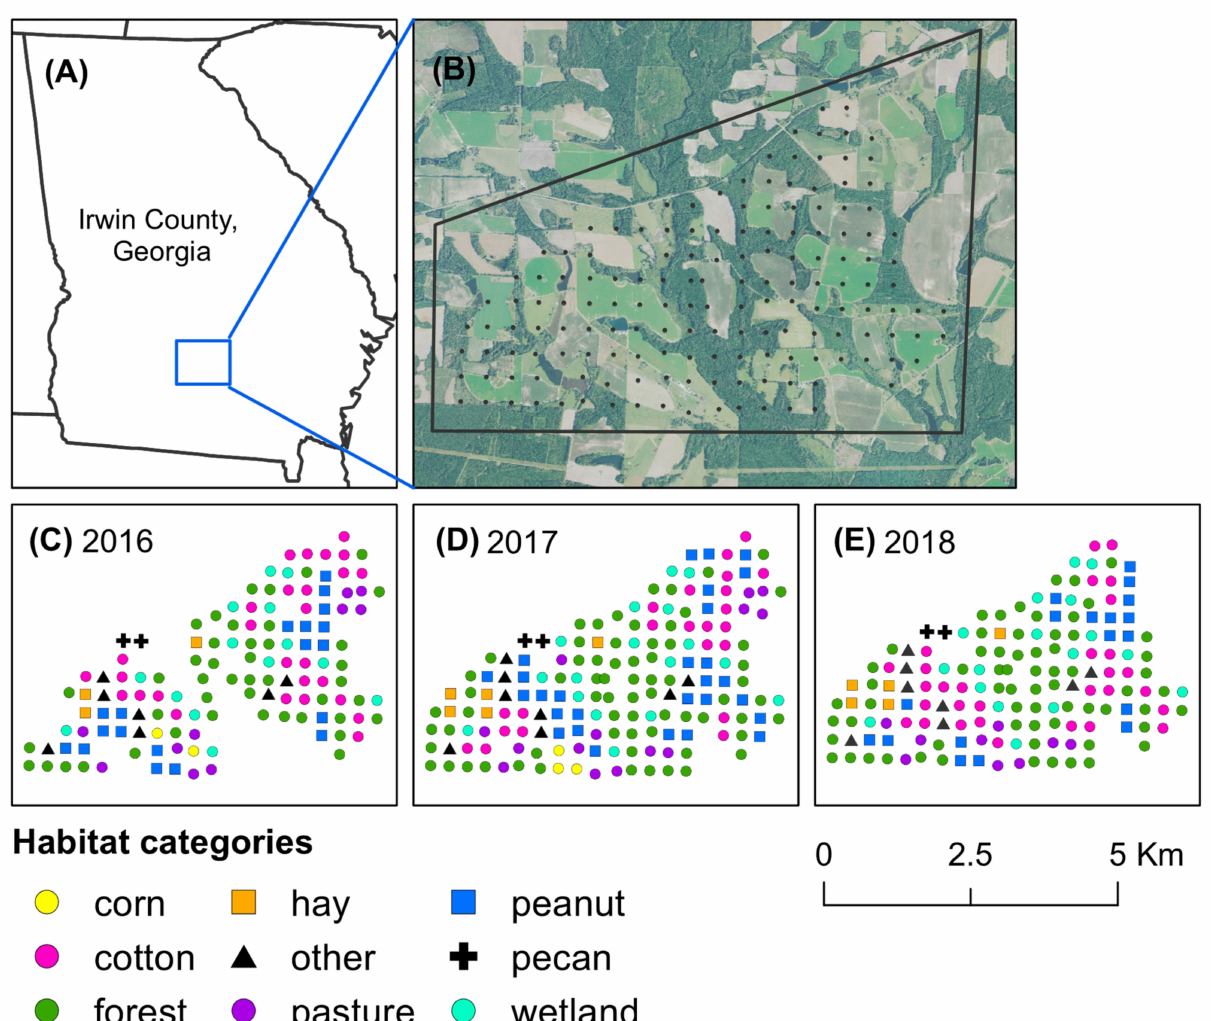
Figure 1. Map of Irwin County, Georgia, USA, and habitat categories at pheromone-baited traps. The study took place in ( A ) Irwin County, Georgia, where stink bugs were captured across ( B ) an 18 km 2 agricultural landscape. Habitats at each trap site were categorized for ( C ) 2016, ( D ) 2017, and ( E ) 2018, based on predominant land use